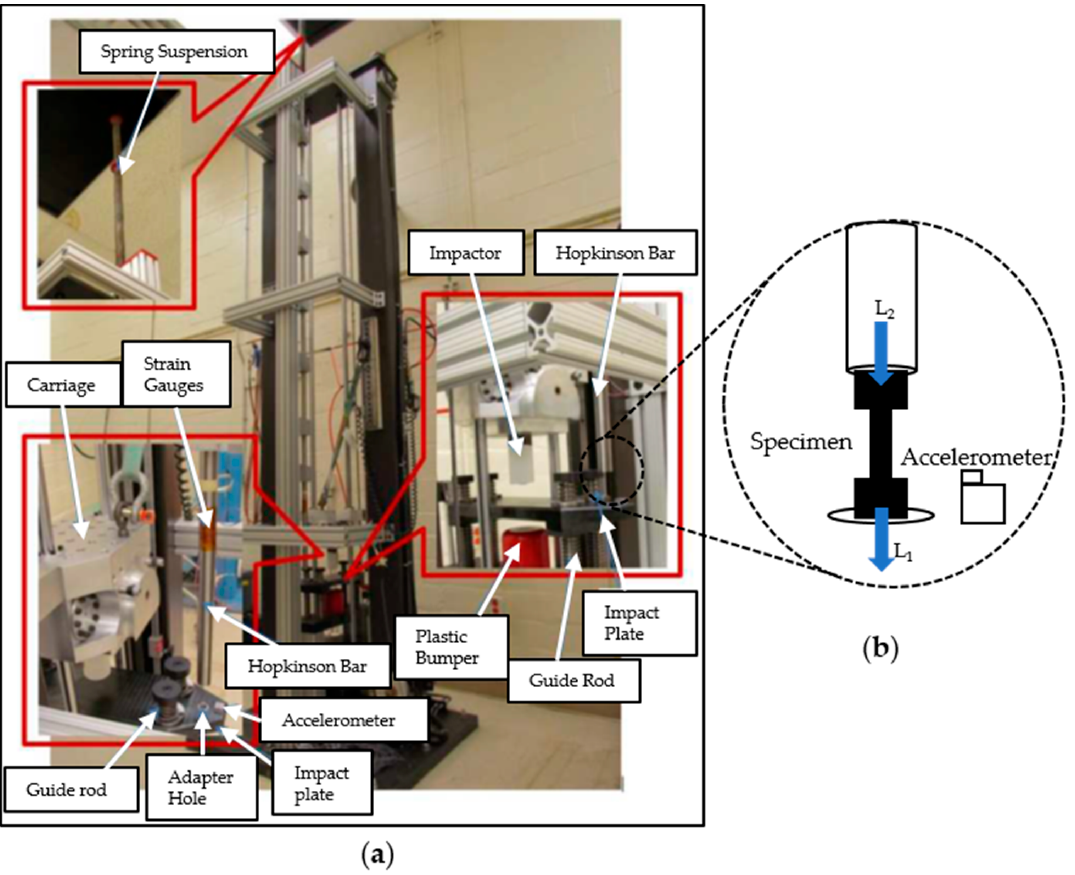
Figure 3. ( a ) Overall view of Dropkinson bar test and ( b ) illustration of specimen displacement measurements (the figure is reproduced from [42], with the permission from authors & EPJ Web of Conferences (open access),